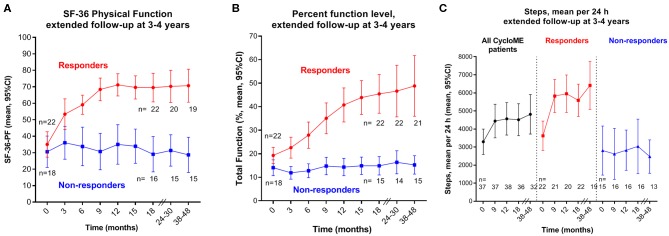
Outcome variables at extended follow-up, by response status. Means with 95% CI at different time points including extended follow-up at 24–30 and at 38–48 months. (A): SF-36 Physical Function (SF-36-PF); (B) percent function level; (C): mean steps per 24 h. Numbers of patients at the different time points through follow-up are shown below the graphs. SF-36, Short Form 36; CI, confidence intervals.